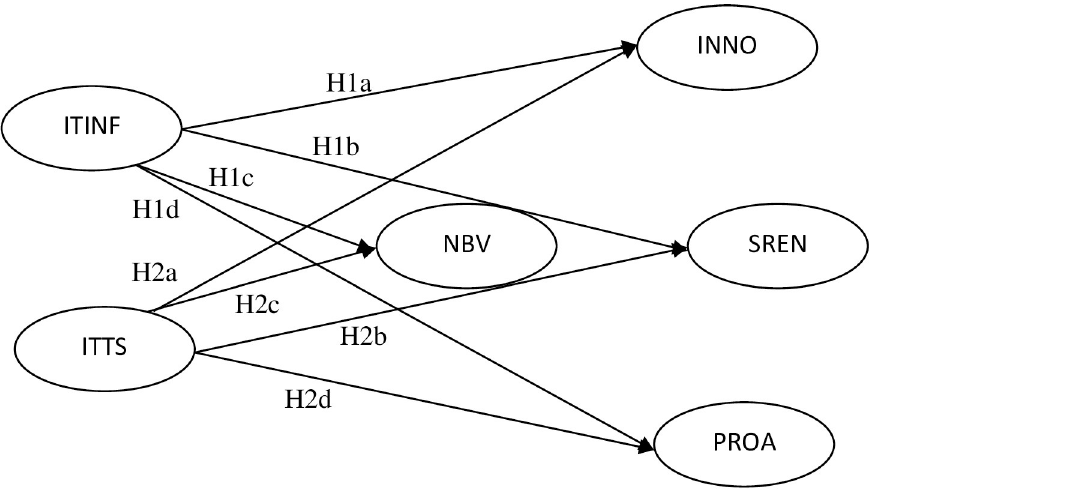
Fig 1. Conceptual model, Stage I. ITINF = IT Infrastructure Flexibility, ITTS = IT Technical Skills, NBV = New Business Venturing, INNO = Innovation, PROA = Proactiveness, SREN = Self-renewal.